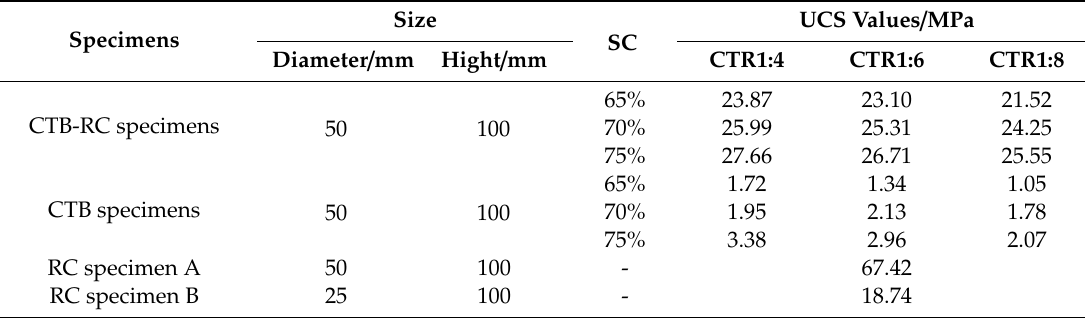
Table 5. The UCS values of di ff erent types of